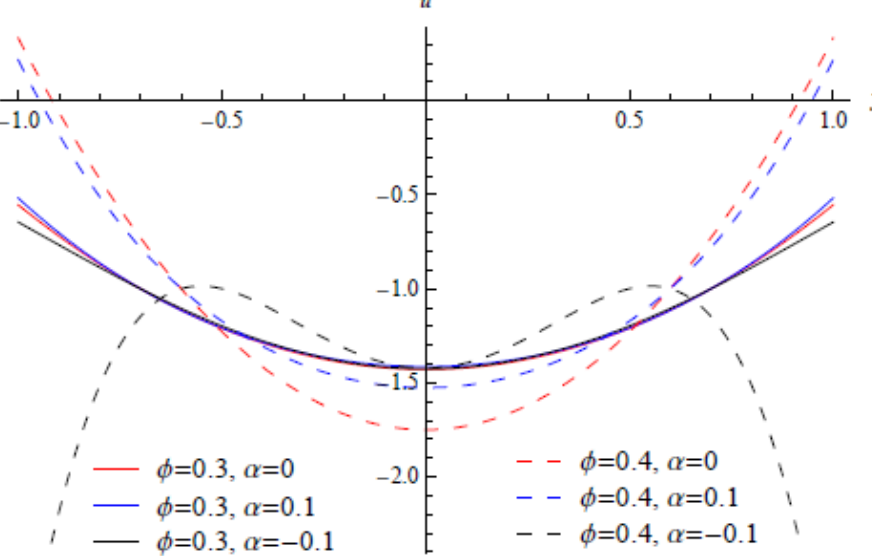
Fig. 7 (b). Velocity profile for different value of , 